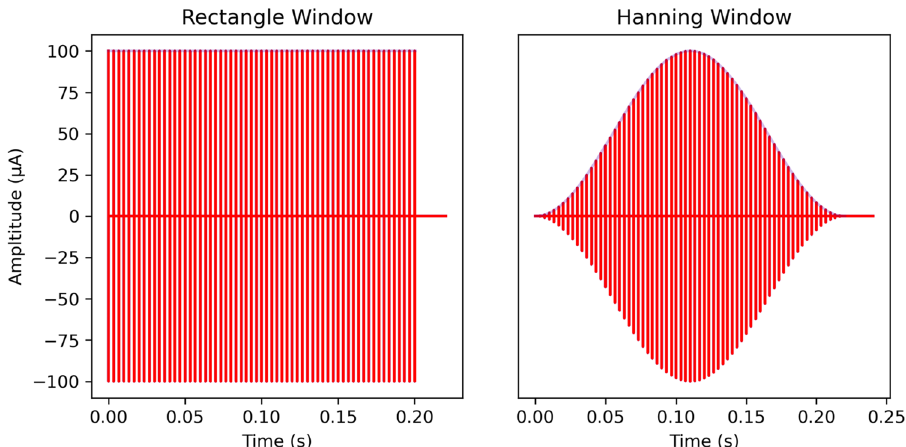
Figure 5. Waveforms of the electrical stimuli for rectangular (left) and Hanning (right) windowed stimulation. Waveforms shown are examples at 300